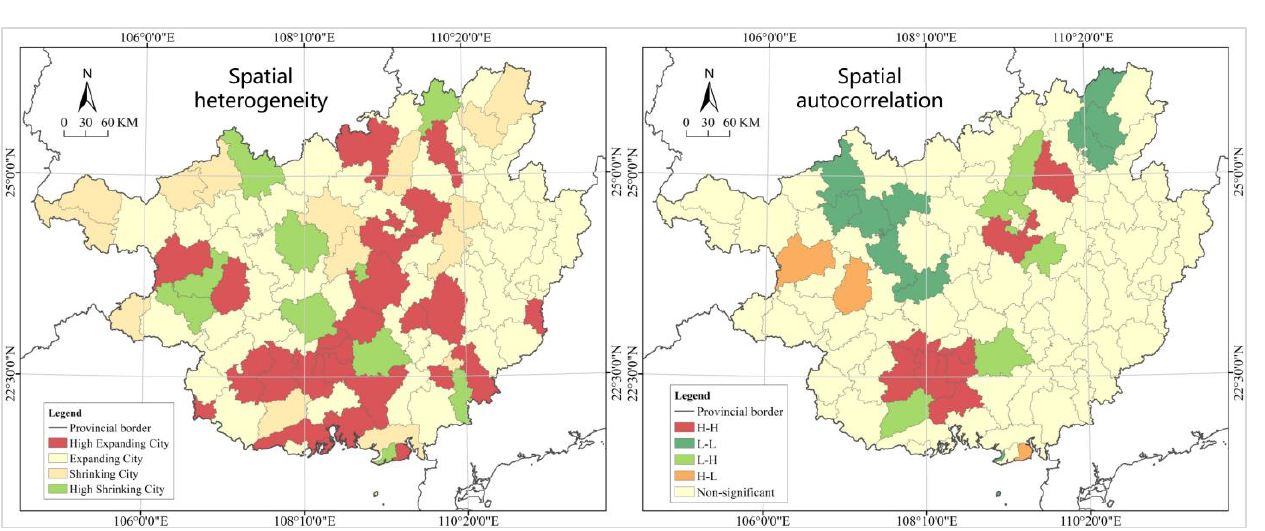
Figure 10. Spatial analysis of night light extended vitality index changes in Guangxi .